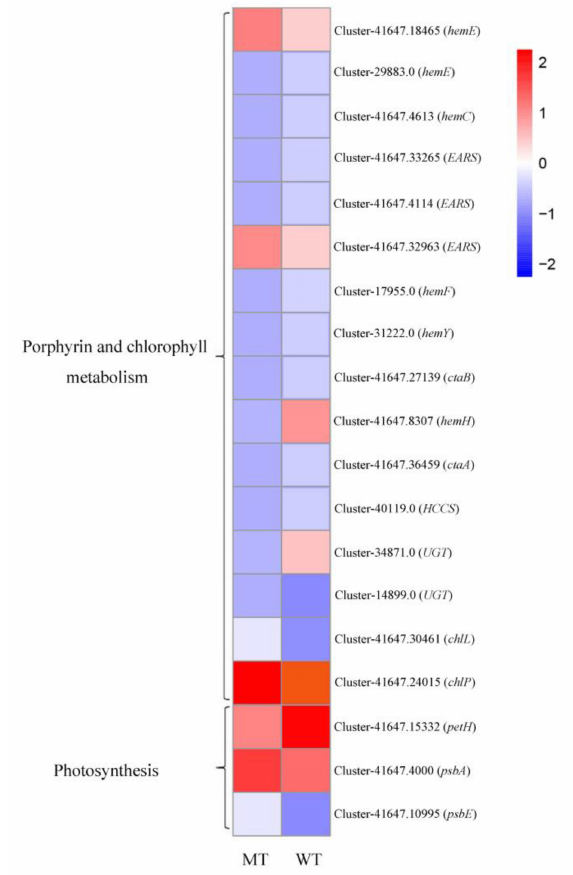
Figure 4. Heat maps of the differentially expressed unigenes involved in related pathways in leaves of mutant-type and wild-type Torreya grandis ‘Merrillii’. WT means wild type; MT means yellow leaf mutant type; the transcriptome data (FPKM) were used to create the heat